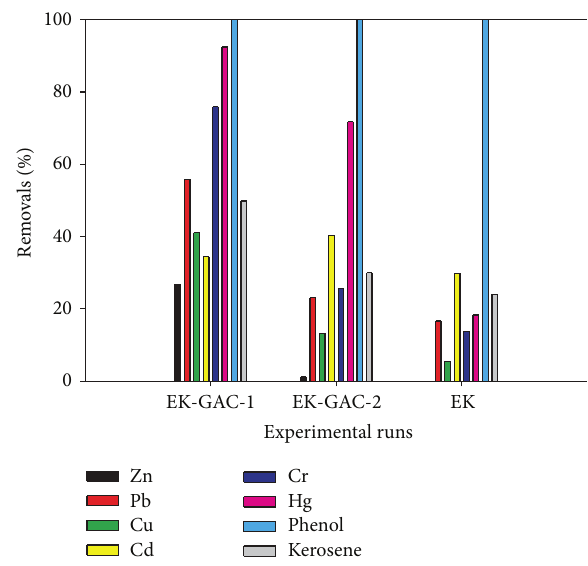
Figure 7: Comparison of the contaminant removal efficiencies for all the